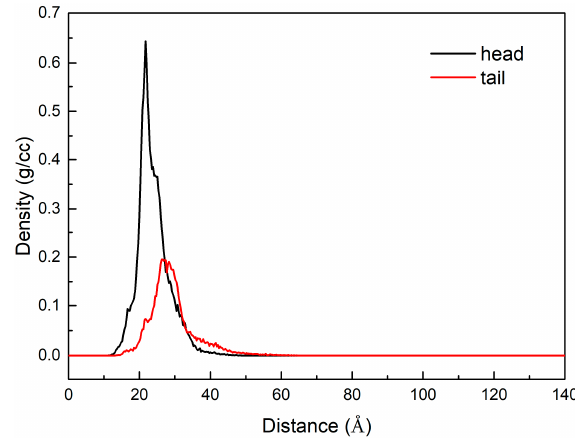
Figure 5. Density profiles of the NPEO 10 head group and tail group along the Z direction.